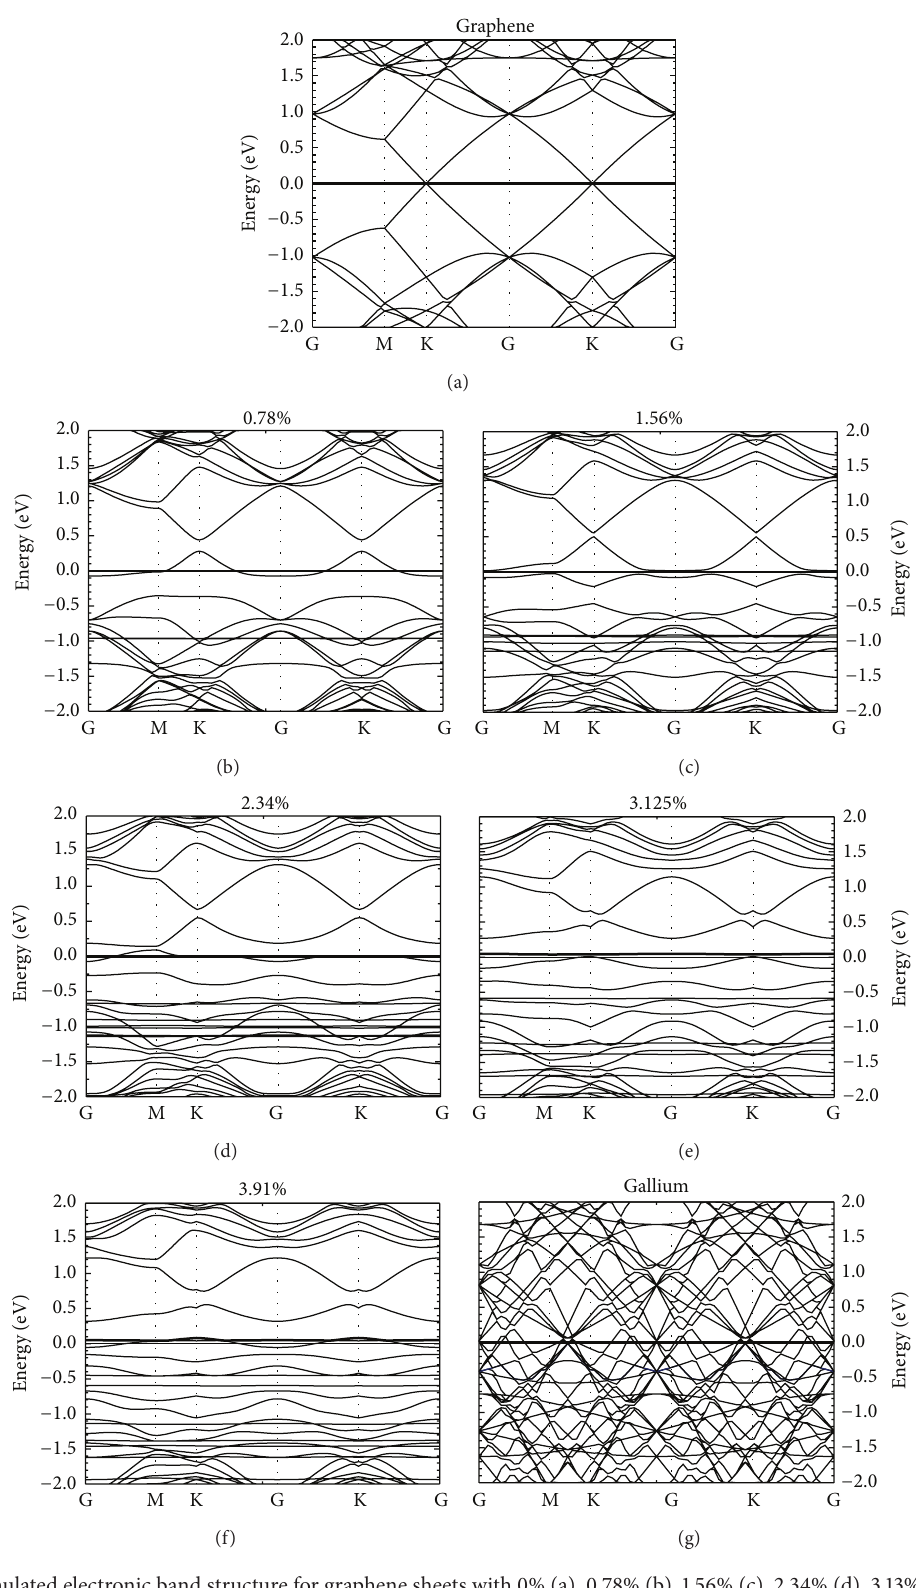
Figure 3: The simulated electronic band structure for graphene sheets with 0% (a), 0.78% (b), 1.56% (c), 2.34% (d), 3.13% (e), 3.91% (f), and 100% (g) substitution of